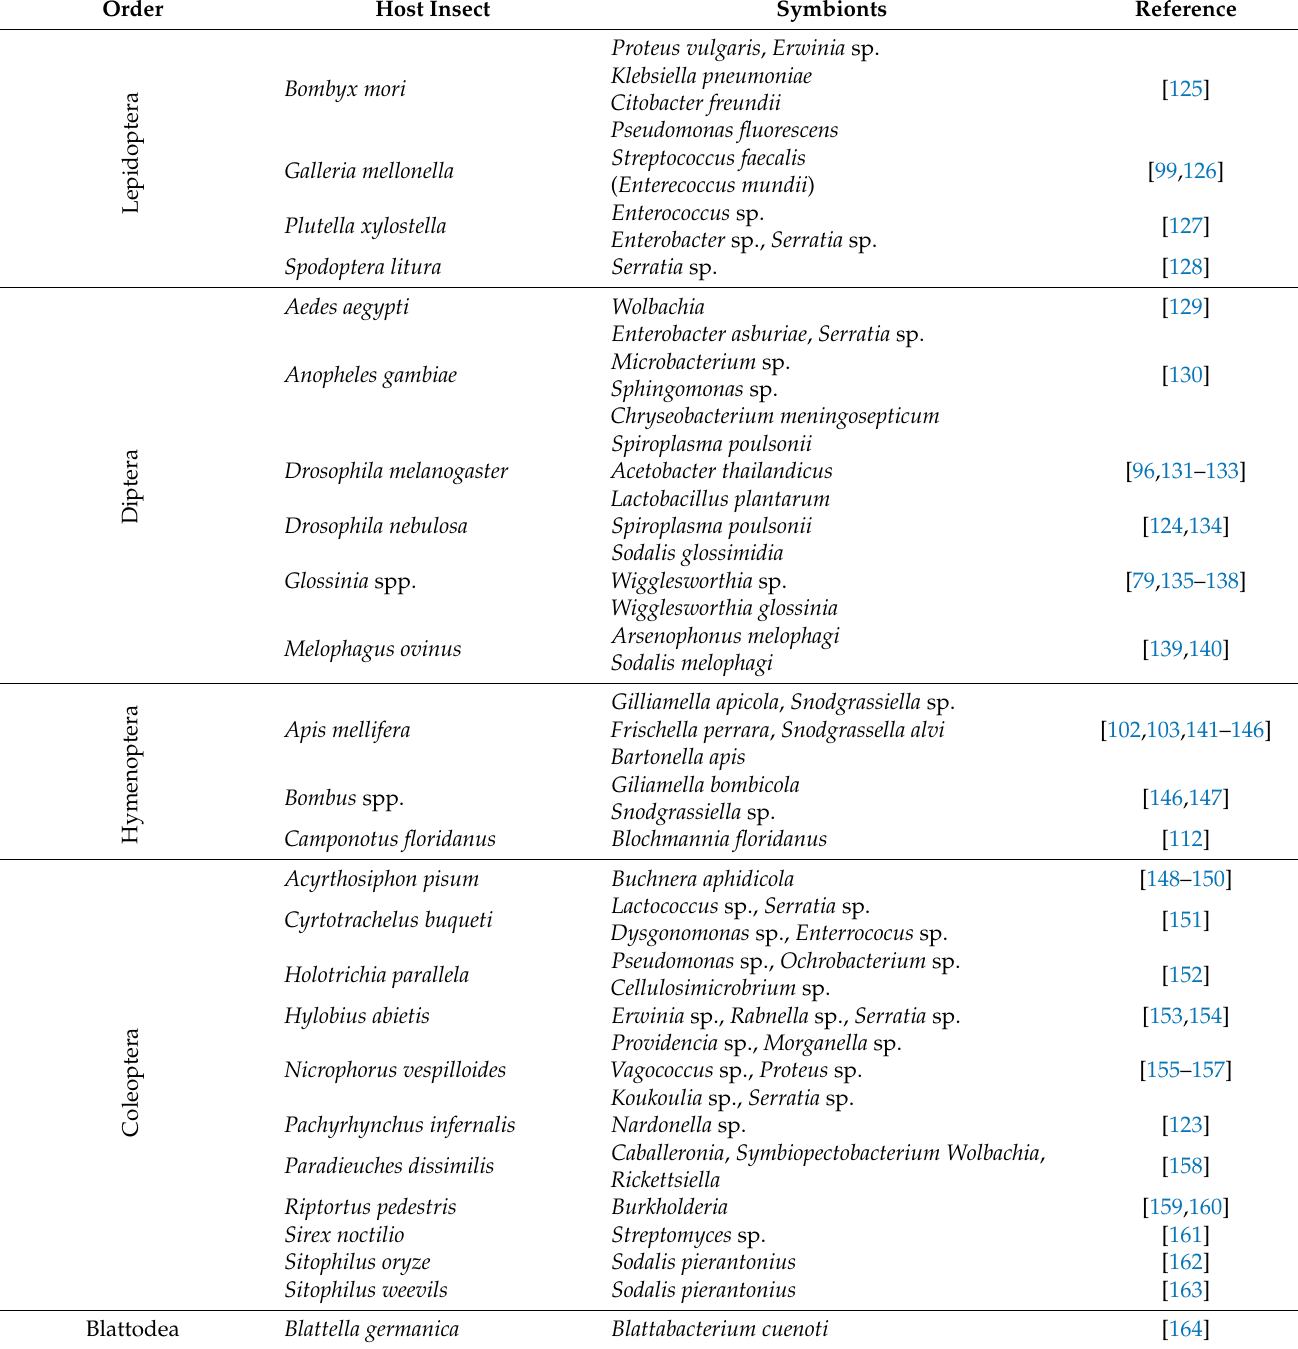
Table 1. Insects and their gut